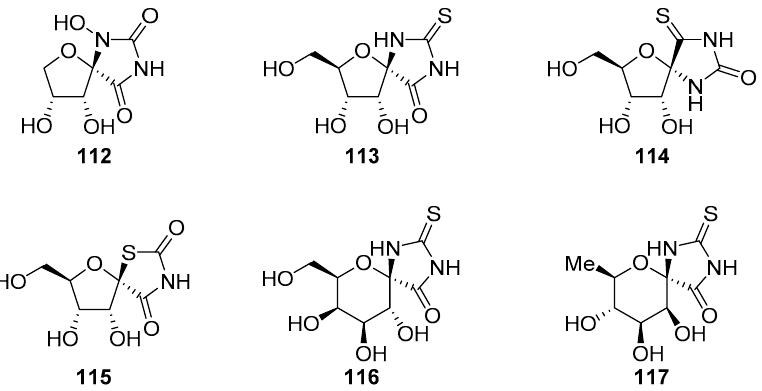
Figure 7. Analogues of hydantocidin modified in the hydantoin ring.